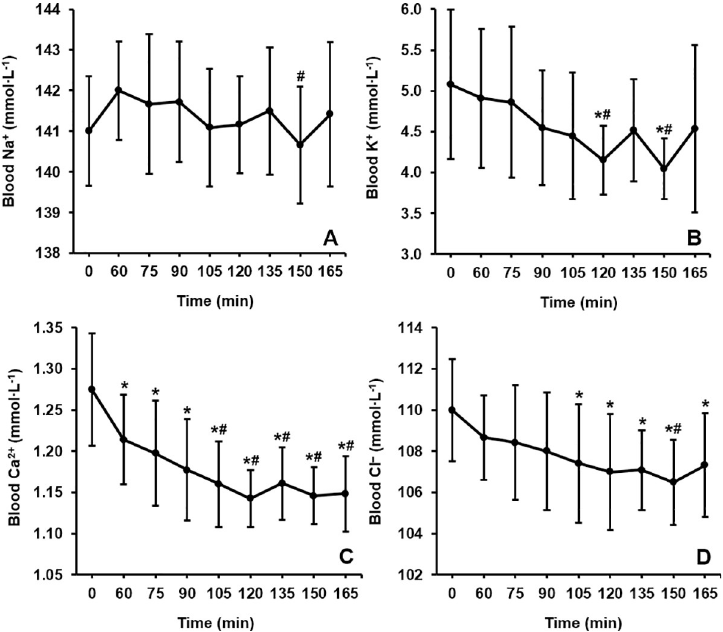
Fig 4. Group mean time course changes in A) blood sodium (K + ), B) potassium (Na + ), C) calcium (Ca 2+ ), and D) chloride (Cl – ) over a 165 min period following NaHCO 3 ingestion. � = a large effect size compared to baseline ( g